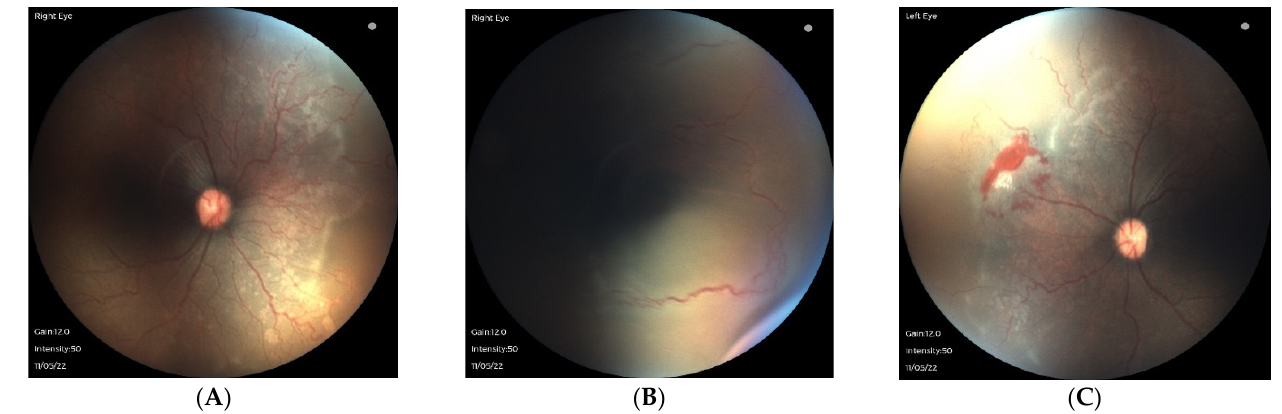
Figure 2. Retinal pathology photographed at 36 weeks’ post-menstrual age in a preterm infant born at 32 weeks and 1500 g, exposed to 100% oxygen. ( A ) The right eye has shunt vessels extending beyond the vascular–avascular junction superiorly. ( B ) The left eye has an island of avascular retina within otherwise vascularized retina nasally.